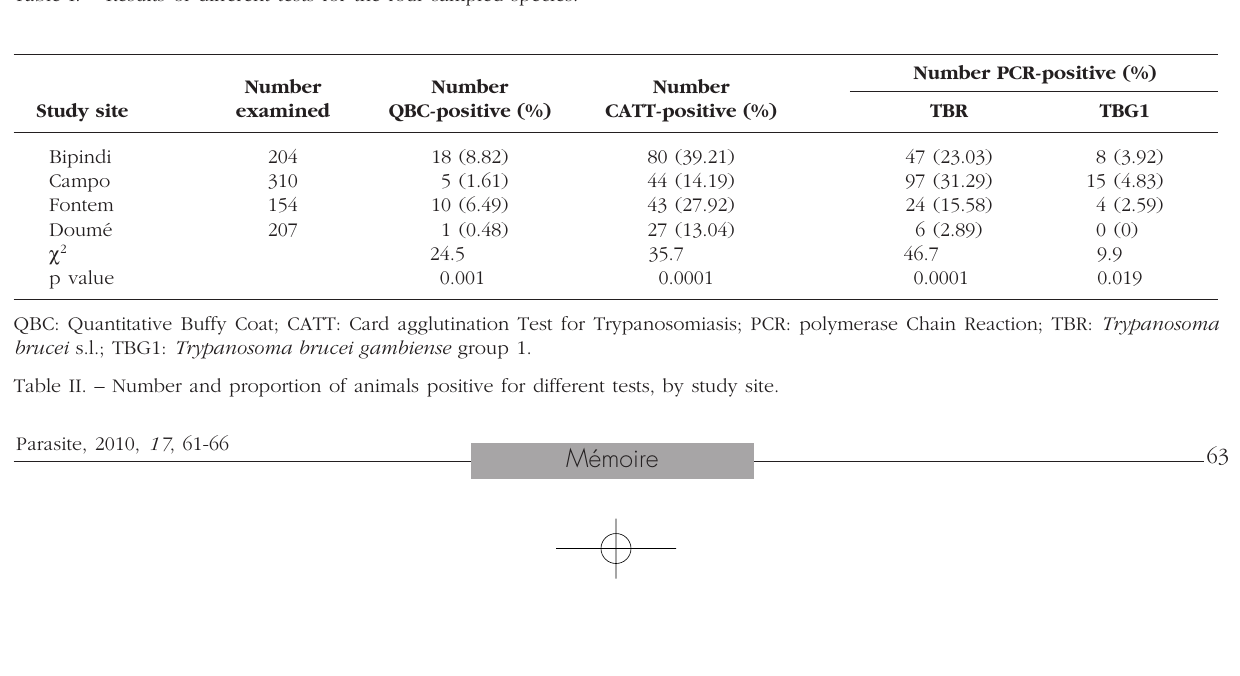
Table I. – Results of different tests for the four sampled species.